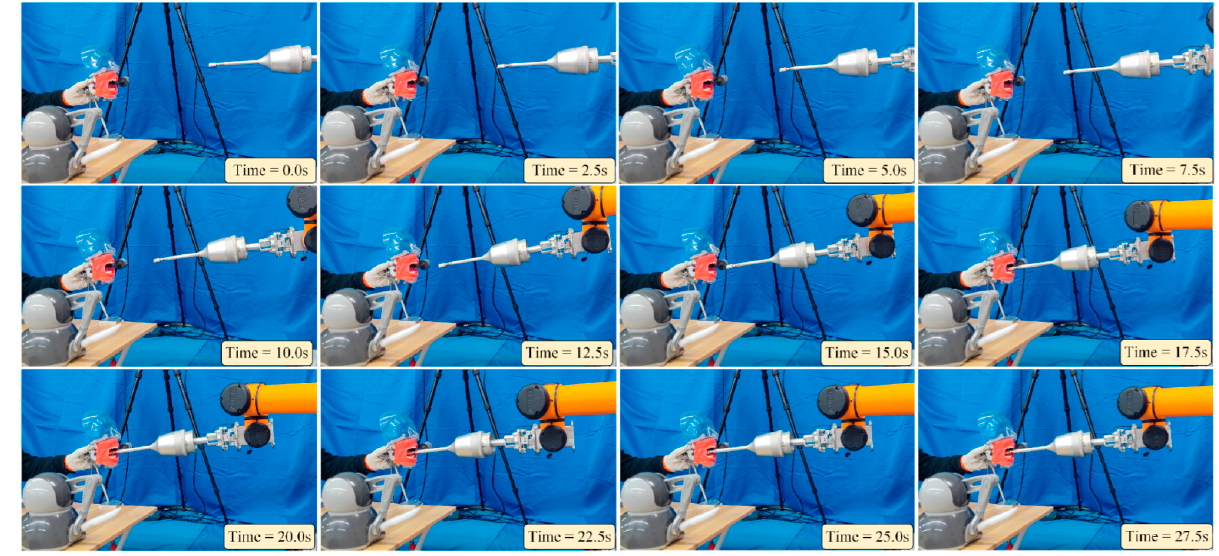
Figure 20. The motion process of dynamic and automatic feeding.